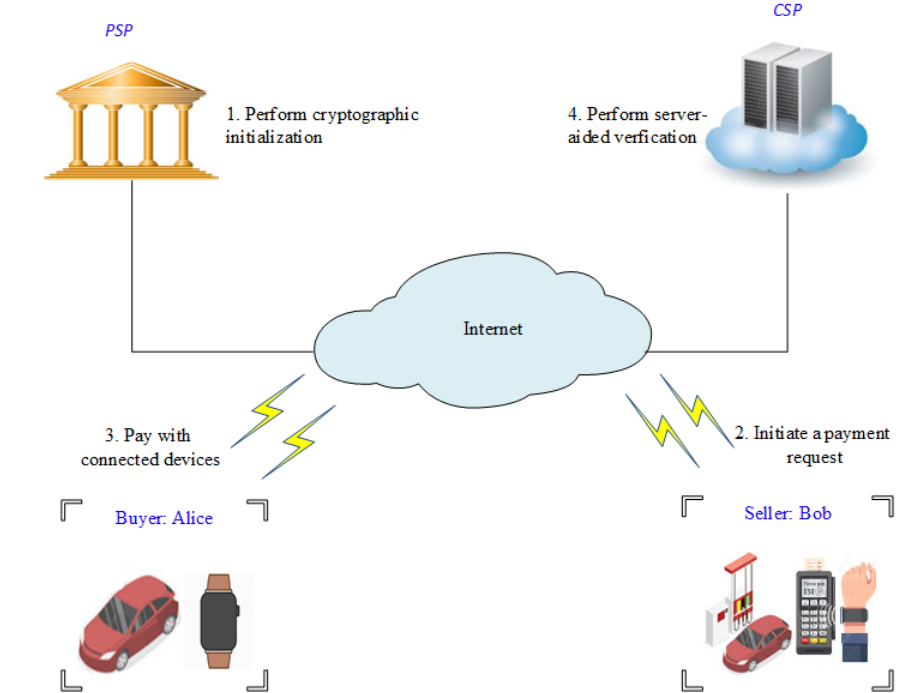
Figure 1. System